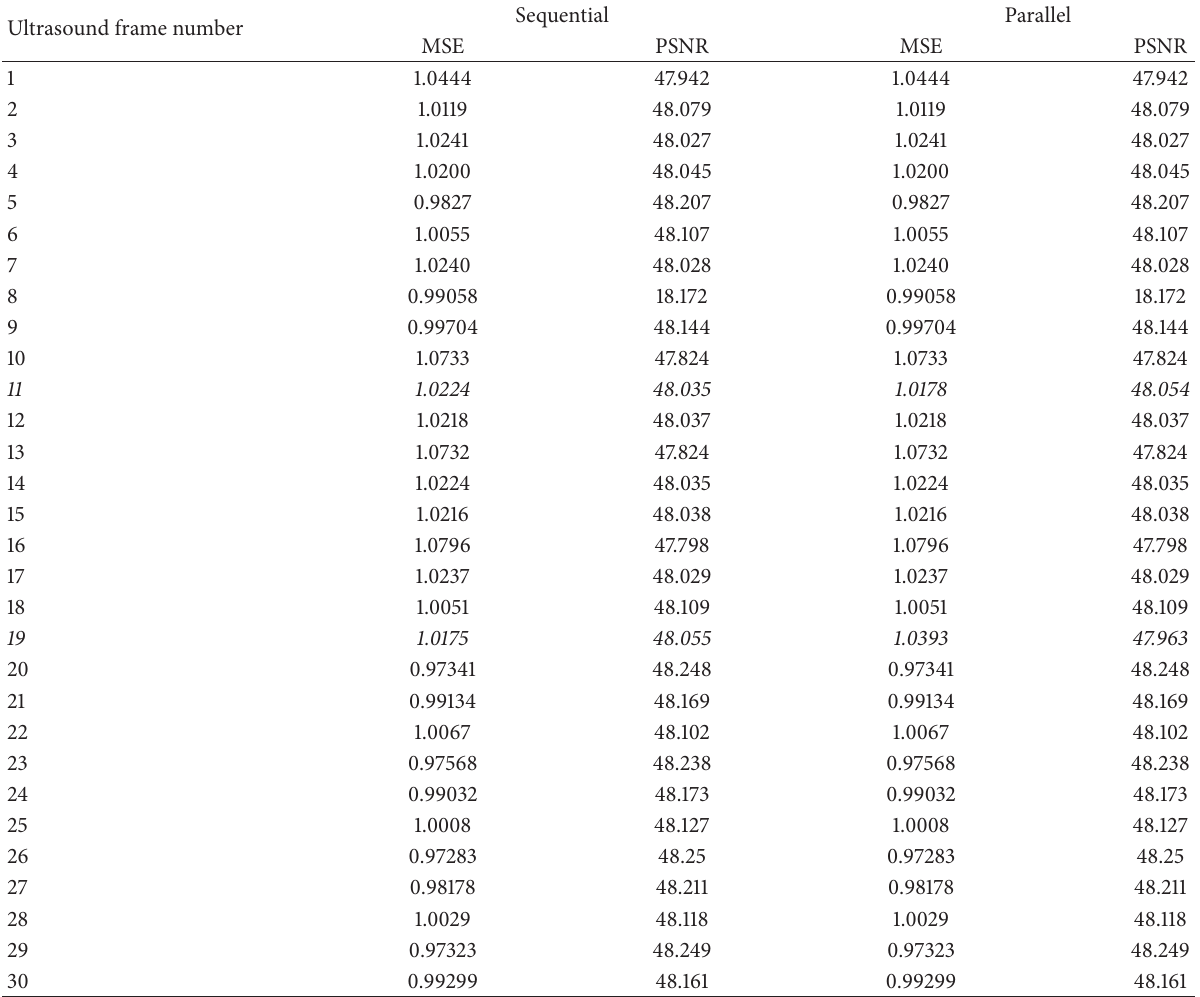
Table 5: PSNR and MSE values for three sets of watermarked ultrasound images produced by watermarking embedding process in different modes: sequential and parallel